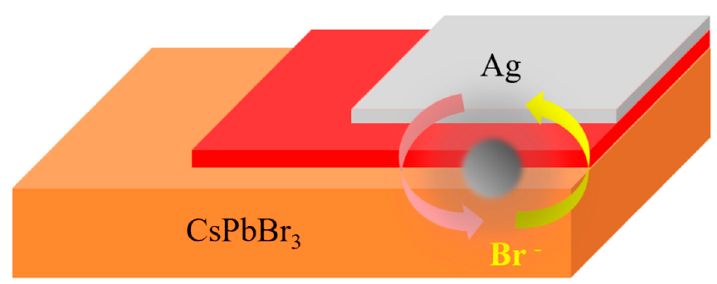
Figure 6. Br − ions migrate into the Ag electrode to produce AgBr precipitation.